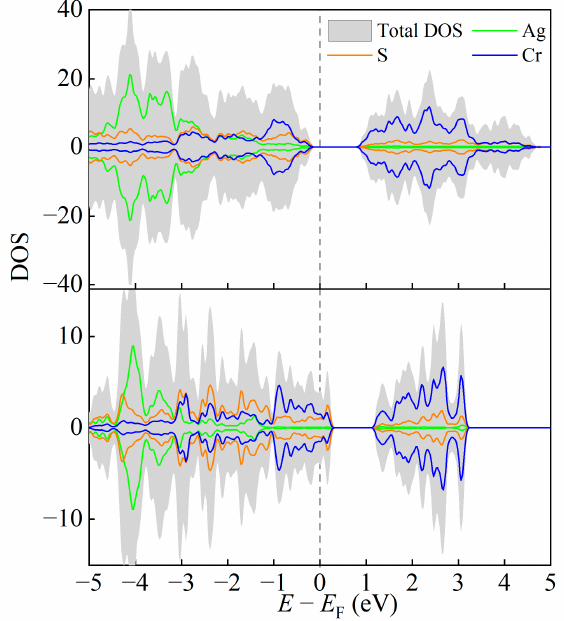
Figure 3. The density of states (DOS) of bulk AgCrS 2 ( upper panel ) and monolayer AgCr 2 S 4 ( lower panel ).